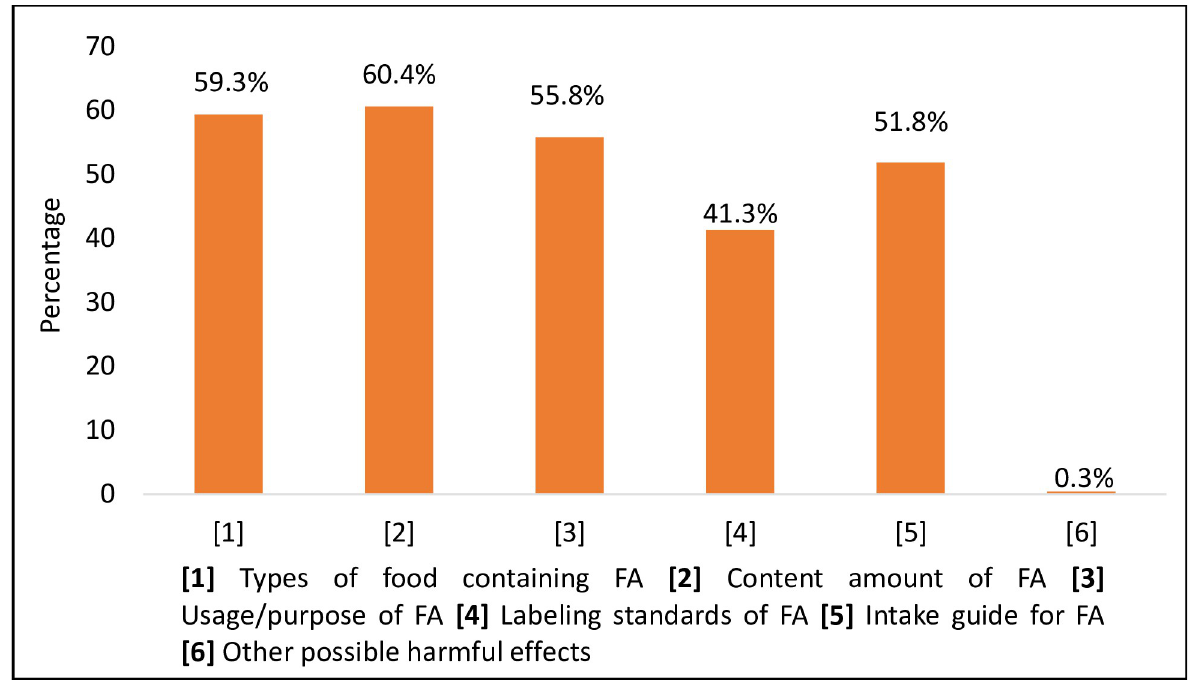
Fig 6. The information about food additives the consumers would like to see (n =